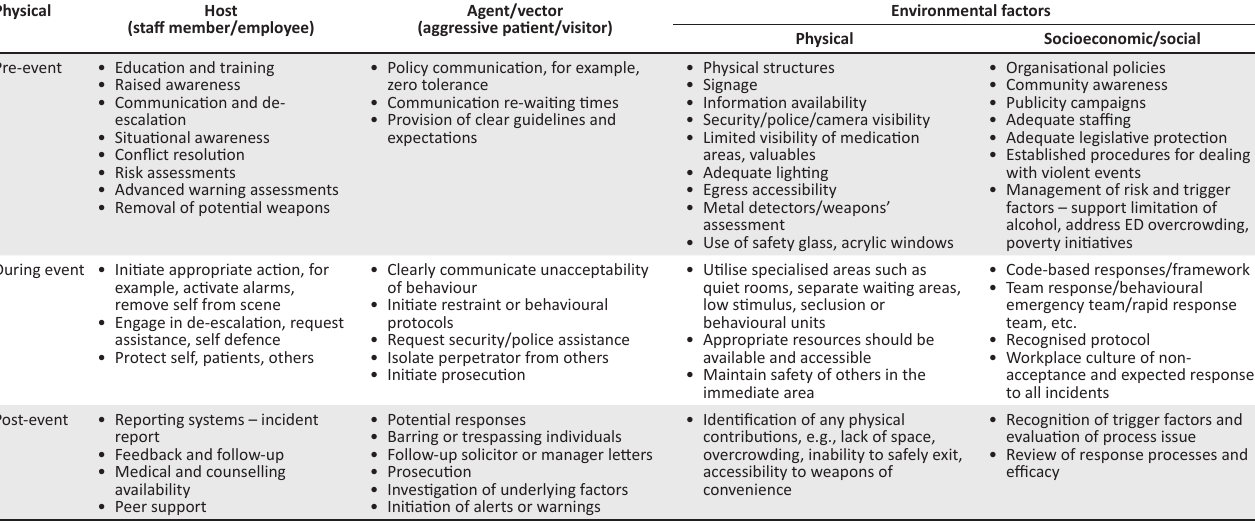
TABLE 3: Haddon matrix in relation to the management of the aggressive patient.